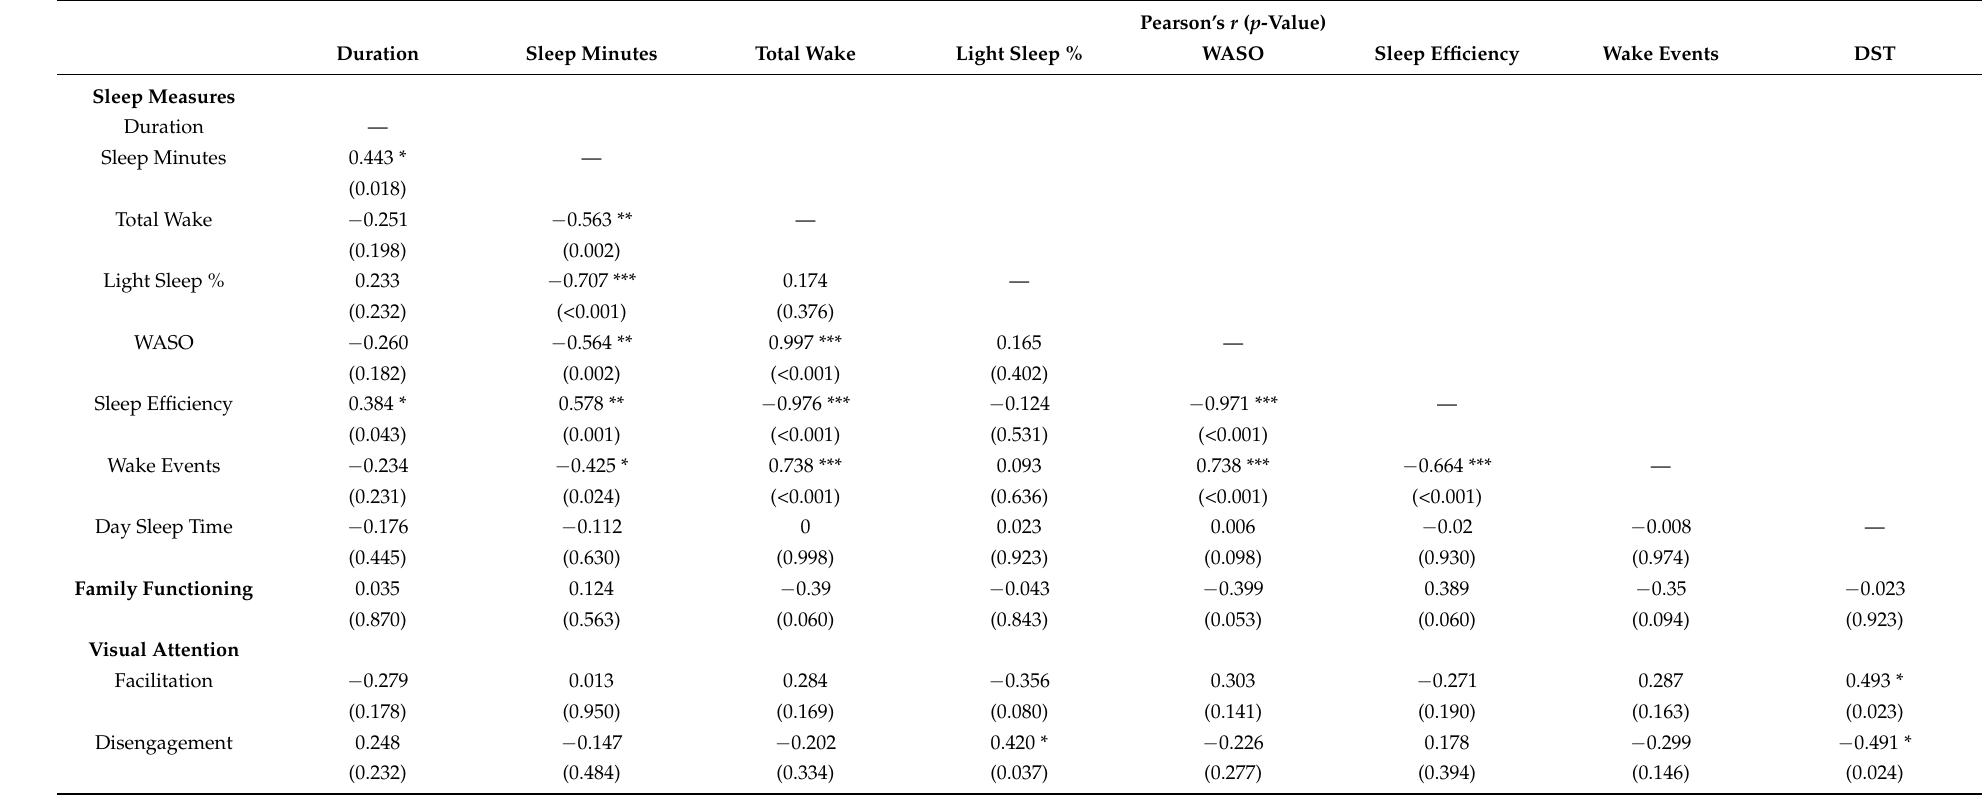
Table 4. Pearson Correlations of all sleep variables with Facilitation and